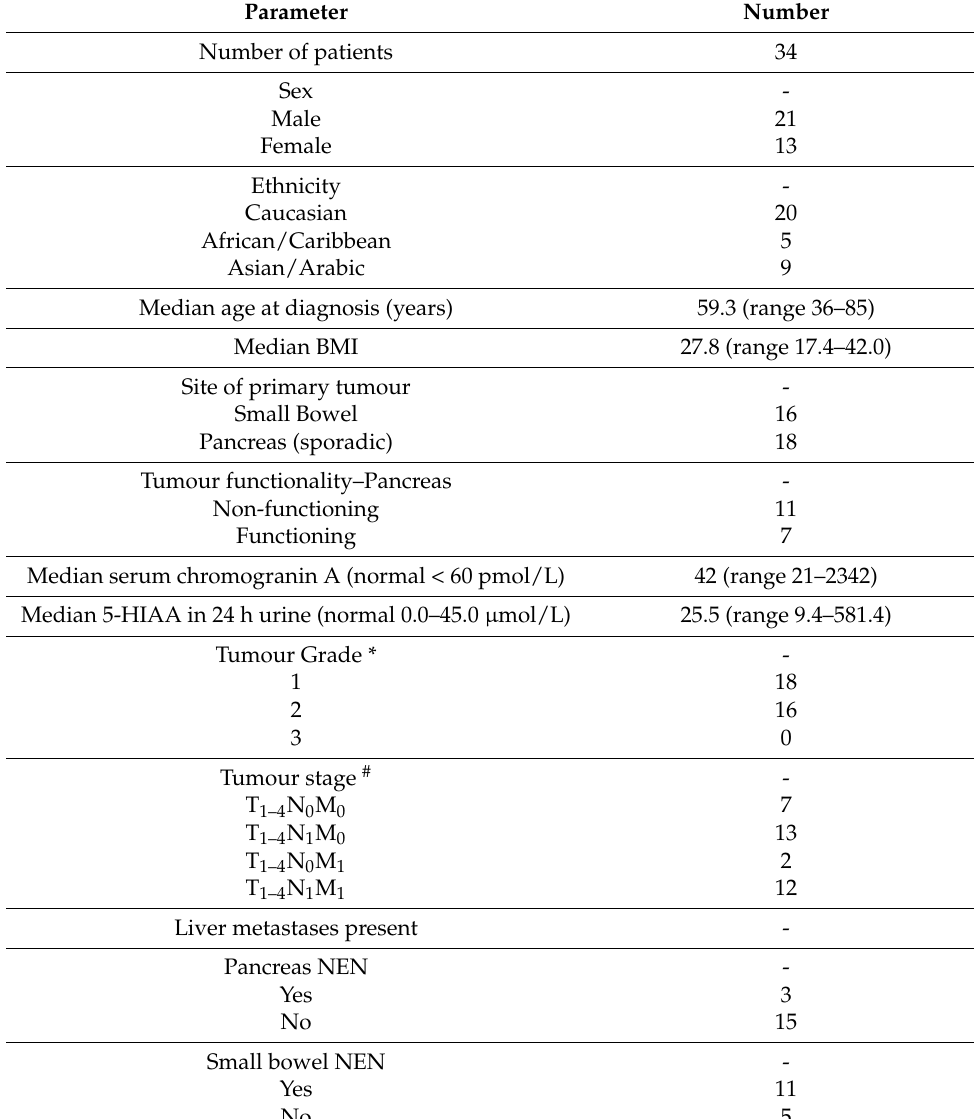
Table 1. Clinicopathological characteristics of neuroendocrine neoplasm patients at study